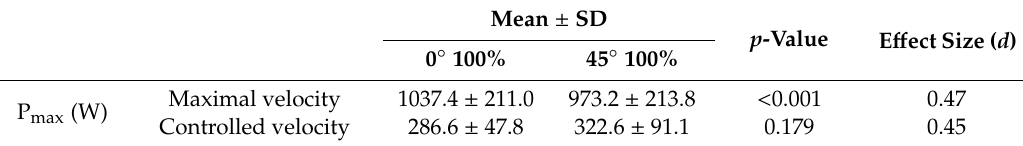
Table 3. Mean, SD, p -value and e ff ect size for the P max comparing the conditions executed at both the maximal and controlled